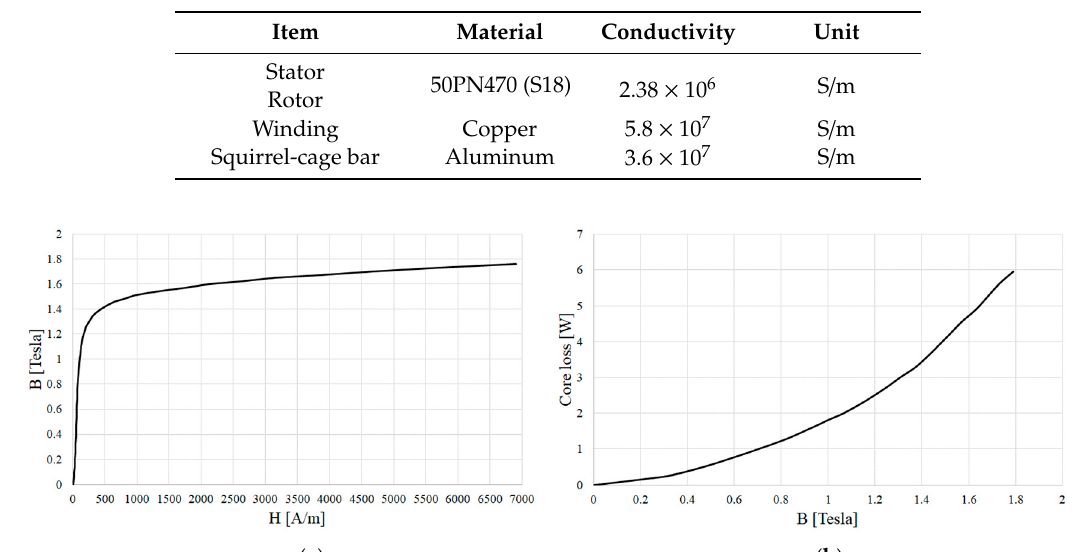
Table 2. The material of each parts for finite element analysis (FEA).